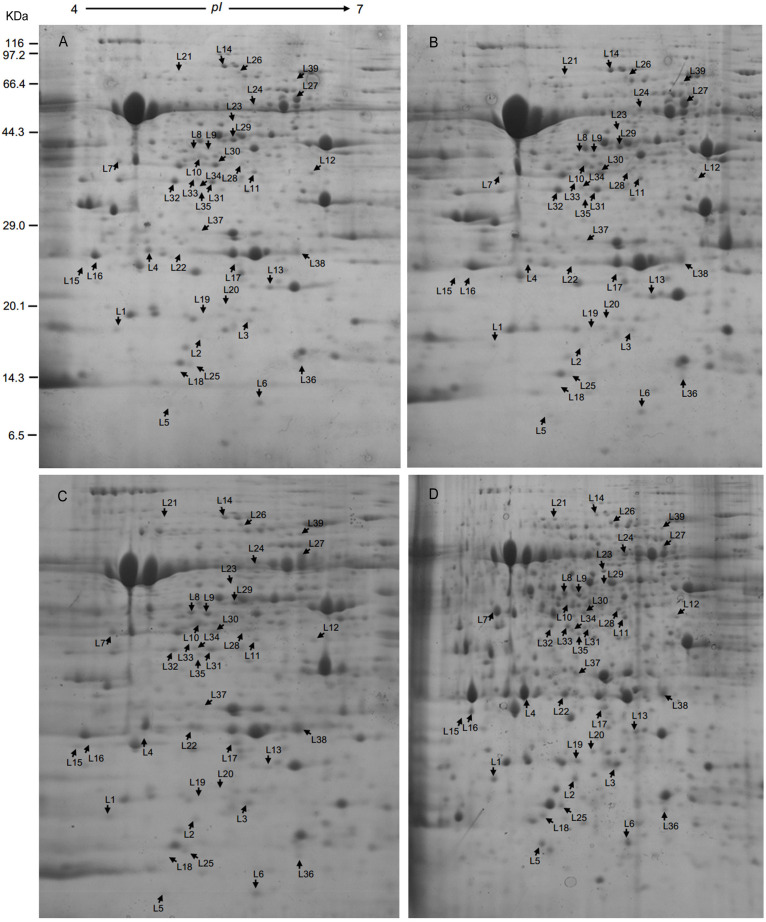
Representative 2-DE gels of proteins extracted from leaves of grafted watermelon seedlings. Proteins extracted from leaves of (A) SG-C, (B) RG-C, (C) SG-FON at 240 hpi, and (D) RG-FON at 240 hpi were focused on IPG strips (11 cm, pH 4–7 NL) and separated by SDS-PAGE (12.5%). Arrows mean the differentially accumulated proteins among RG and SG responding to FON infection.